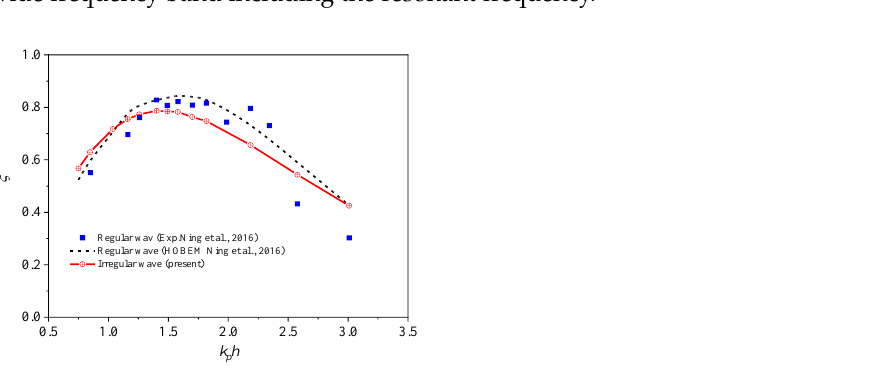
Figure 10. Comparison of the hydrodynamic conversion efficiency versus peak wavenumber between regular and irregular wave conditions.